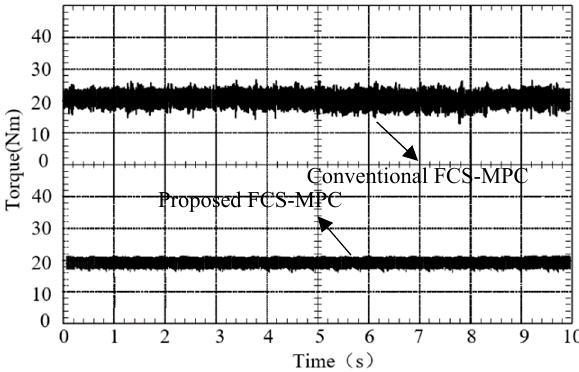
Figure 11. Torque steady-state responses (SPMSM).